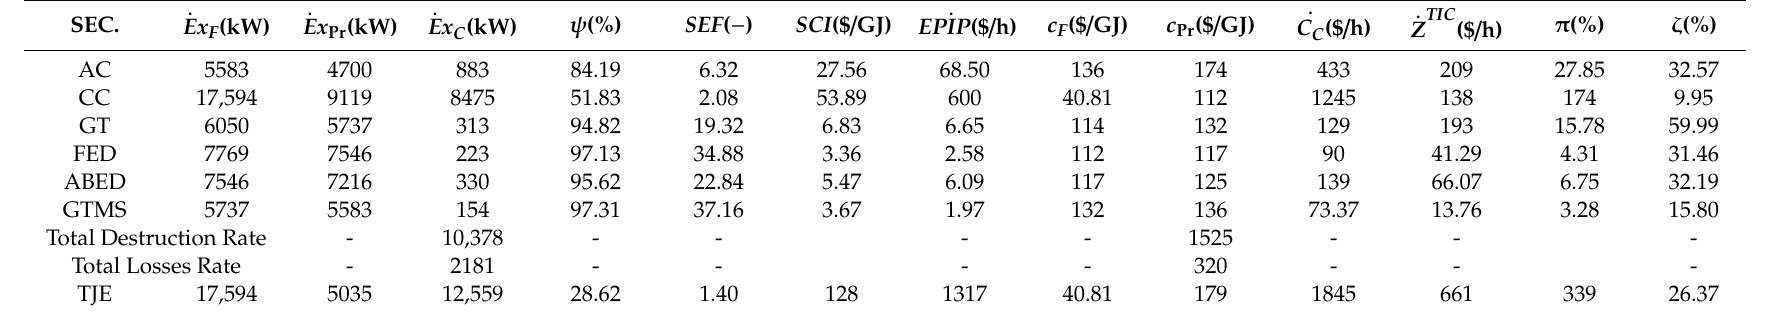
Table 12. Results for exergy, exergoeconomic and sustainability performance indicators for MIL PM with hydrogen fuel use.